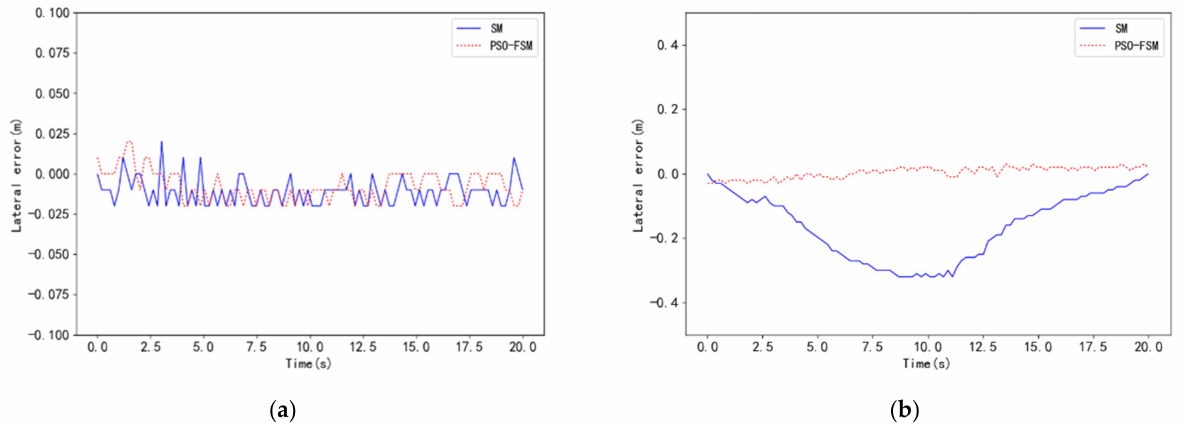
Figure 12. Path tracking result of different algorithms. ( a ) Lateral error of path tracking for straight line; ( b ) Lateral error of path tracking for curve path segment.